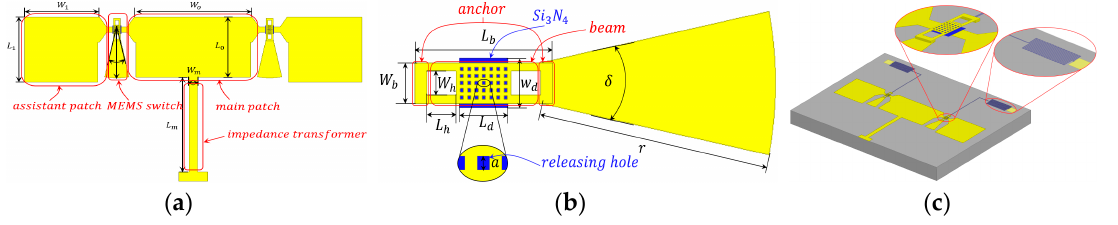
Figure 1. Proposed radiating pattern reconfigurable antenna using micro-electromechanical systems (MEMS) switches. ( a ) Structure of the reconfigurable antenna; ( b ) Structure of the switch used in the reconfigurable antenna; ( c ) Overall structure of the proposed antenna. Table 2. Four operating states and three reconfigurable radiating patterns.